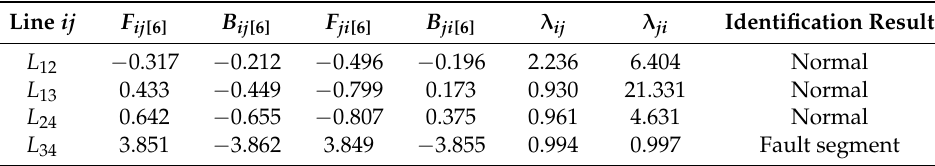
Table 2. Identification results of faulted segment for f 2 fault.